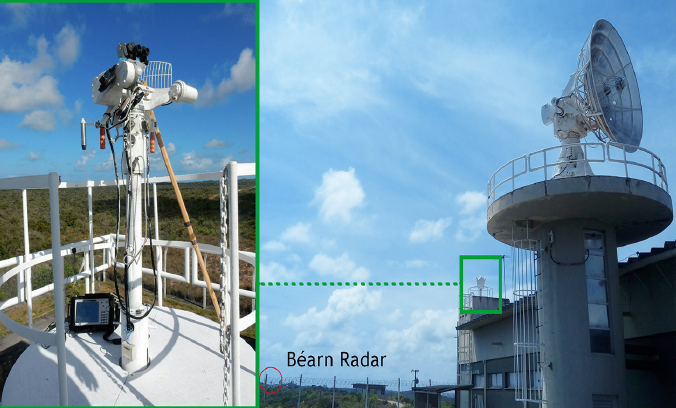
Figure 4. P02 measurement point: Adour’s optic designation instrument on the ( left ) and its antenna on the ( right ).